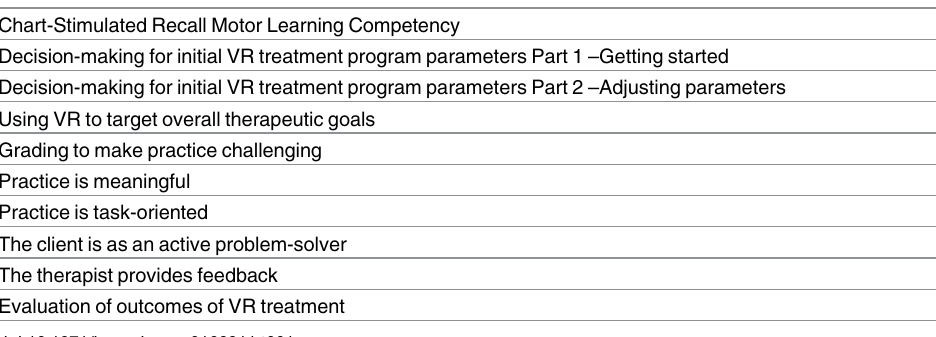
Table 1. Chart-stimulated recall competencies.